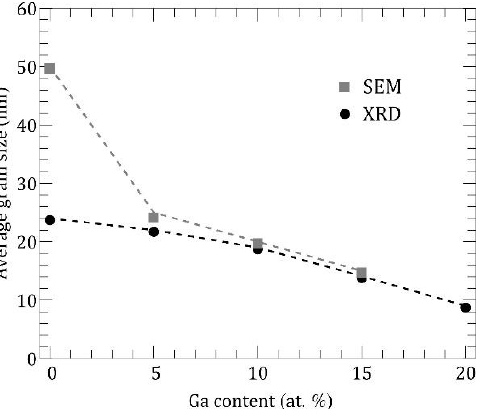
Figure 2. XRD intensity pattern for ITO:Ga films.